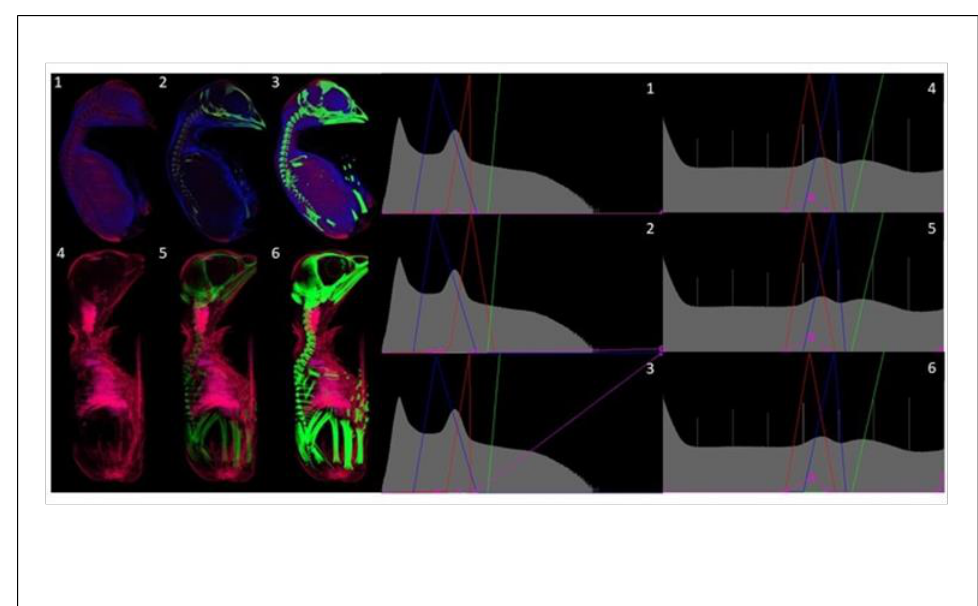
Figure 13. Acquisition voltage comparison in 19 days old chicken. Ethanol, 100 kV (1 – 3) and 40 kV (4 – 6).